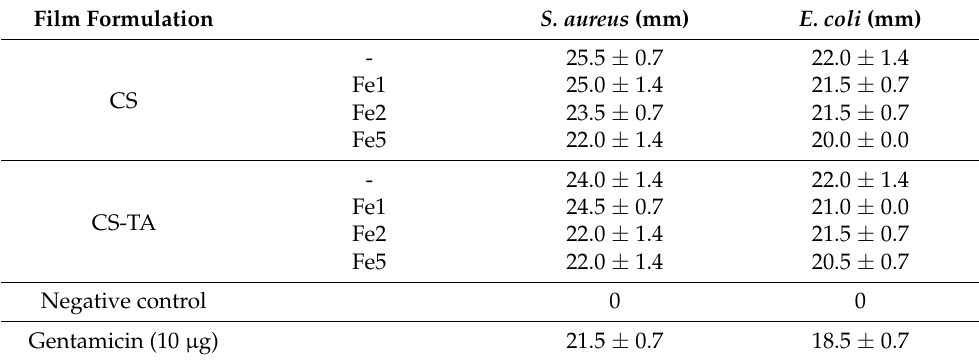
Figure 4. Representative images of disk diffusion (Kirby–Bauer) tests of the G chitosan-based films against the bacteria S. aureus ( top ) and E. coli ( bottom ) after 24 h of incubation. Table 4. Disk diffusion halo diameter measured against S. aureus and E. coli .